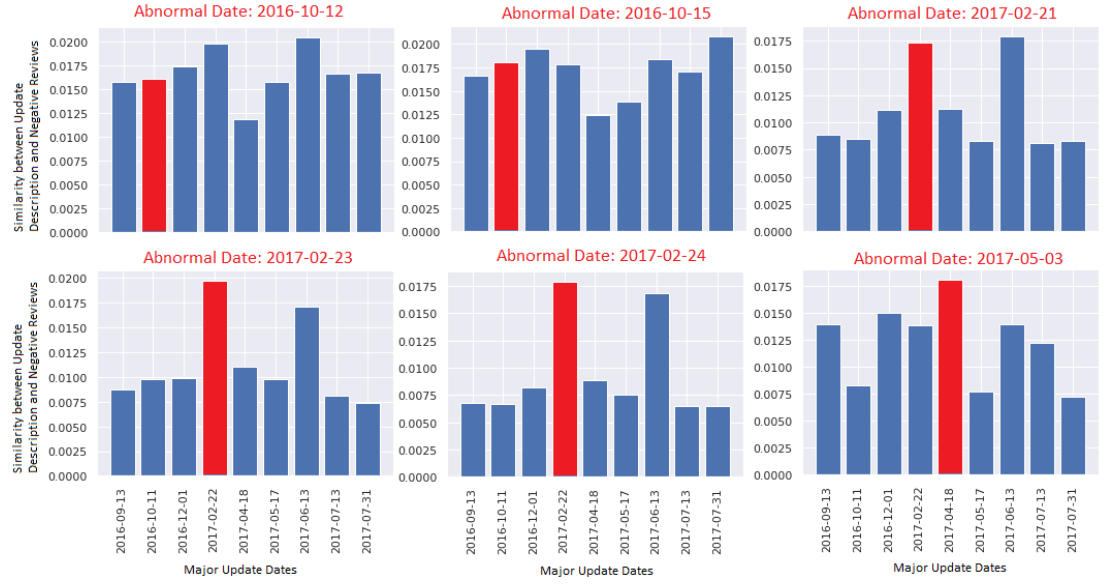
Figure 6. Similarity between update description and negative reviews of abnormal days for Whatsapp.